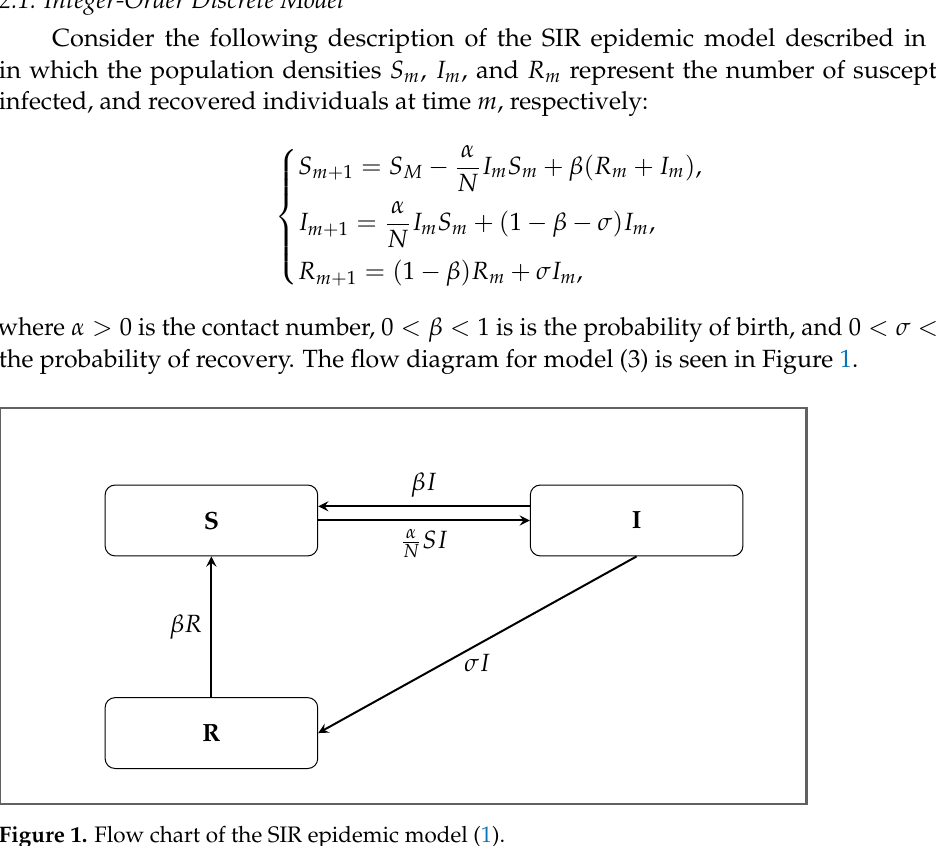
Figure 1. Flow chart of the SIR epidemic model